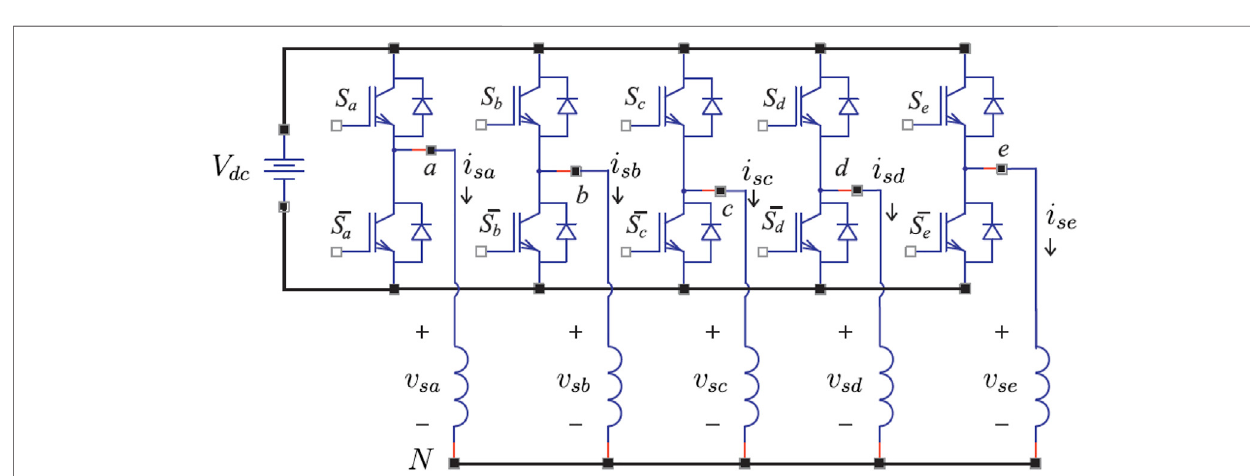
FIGURE 2 | Schematic diagram of the fi ve-phase, two-level